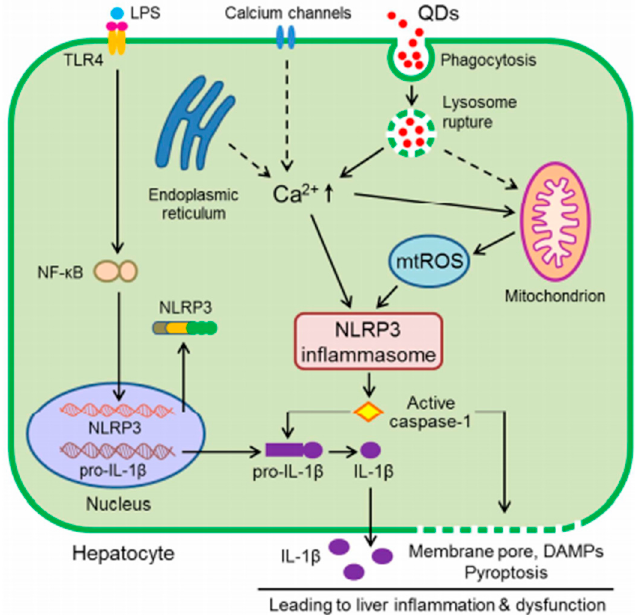
Figure 5. Mechanism of inflammation inducted by QDs. The uptake of QDs triggers a calcium flux inside cells and ROS production, which in turn induces NLRP3 infammasome activation. This phenomenon stimulates IL-1 β maturation, which causes liver inflammation. Reprinted from reference [143]. Copyright (2016), with permission from Elsevier.